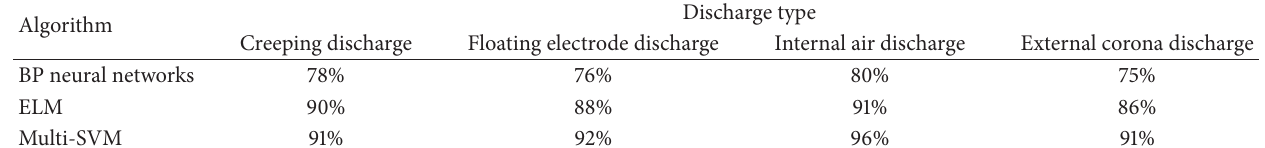
Table 12: Accuracy